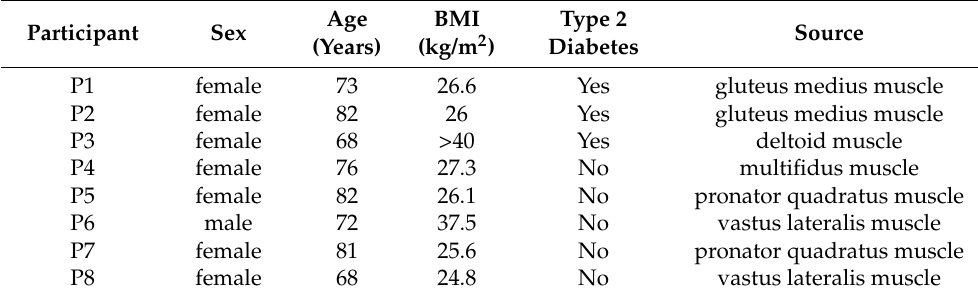
Table 1. Characteristics of the study